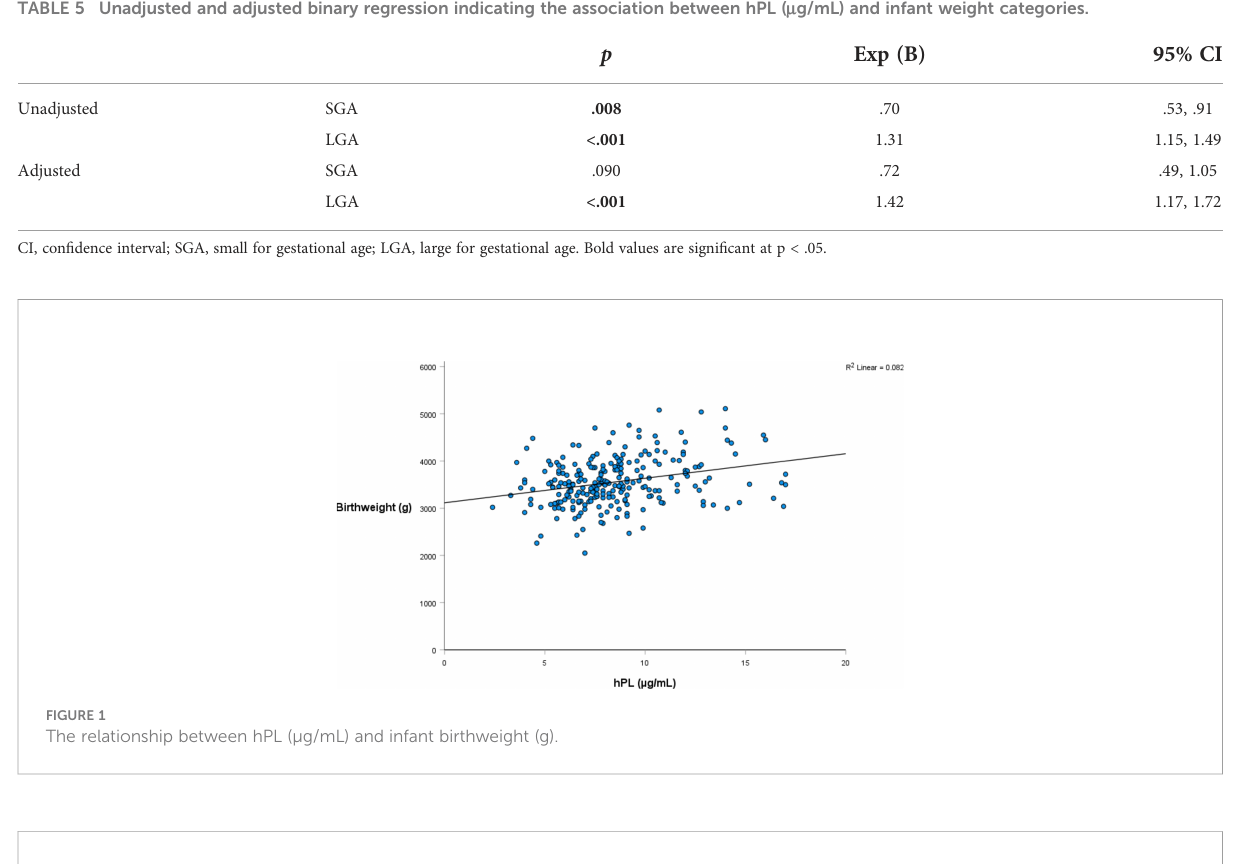
TABLE 5 Unadjusted and adjusted binary regression indicating the association between hPL ( m g/mL) and infant weight categories.